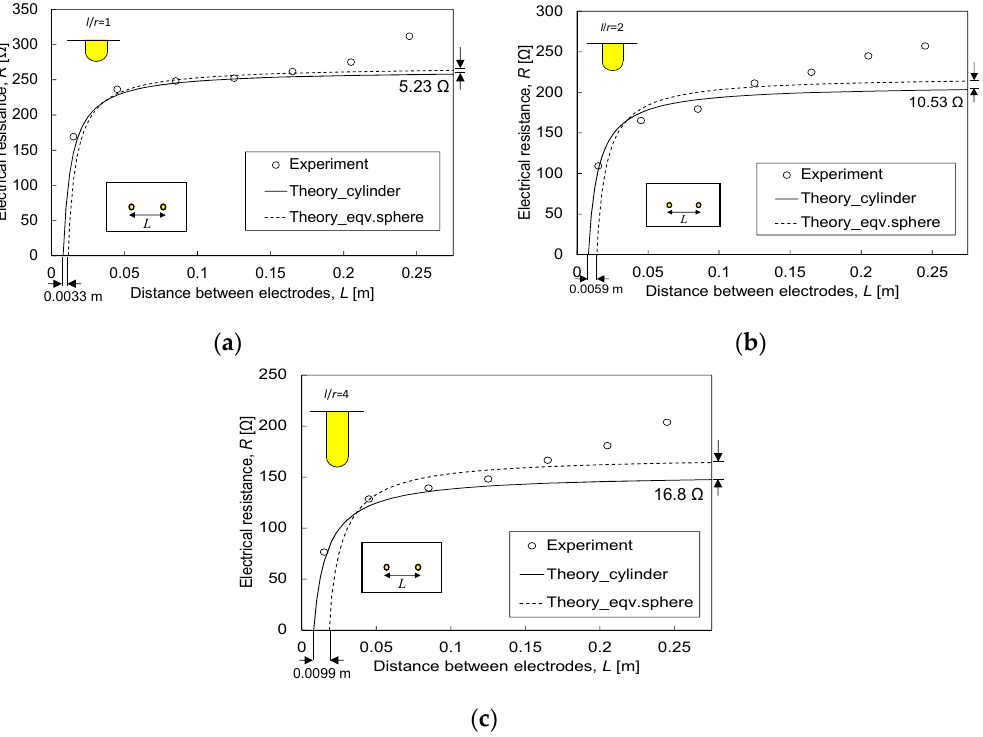
Figure 6. Experimental test results (4.78 Ω m): ( a ) l / r = 1, ( b ) l / r = 2, and ( c ) l / r = 4. Continuous lines are obtained from Equation (9) and dashed lines are gained from Equation (15) by replacing r from Equation (16).